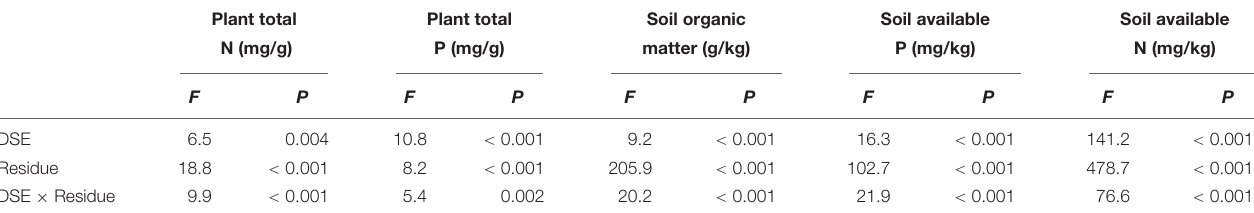
TABLE 3 | Analysis of variance (ANOVA) for the effects of dark septate endophyte (DSE) inoculation and residue treatment (Residue) on the plant and soil nutrient content of liquorice plants. Plant total Plant total Soil organic Soil available Soil